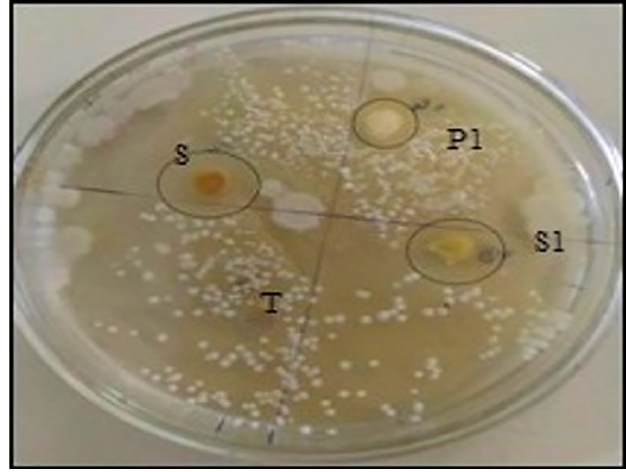
FIGURE 10 - Comparison of antifungal activity of formulation S1 and P1 against Candida albicans by cup plate